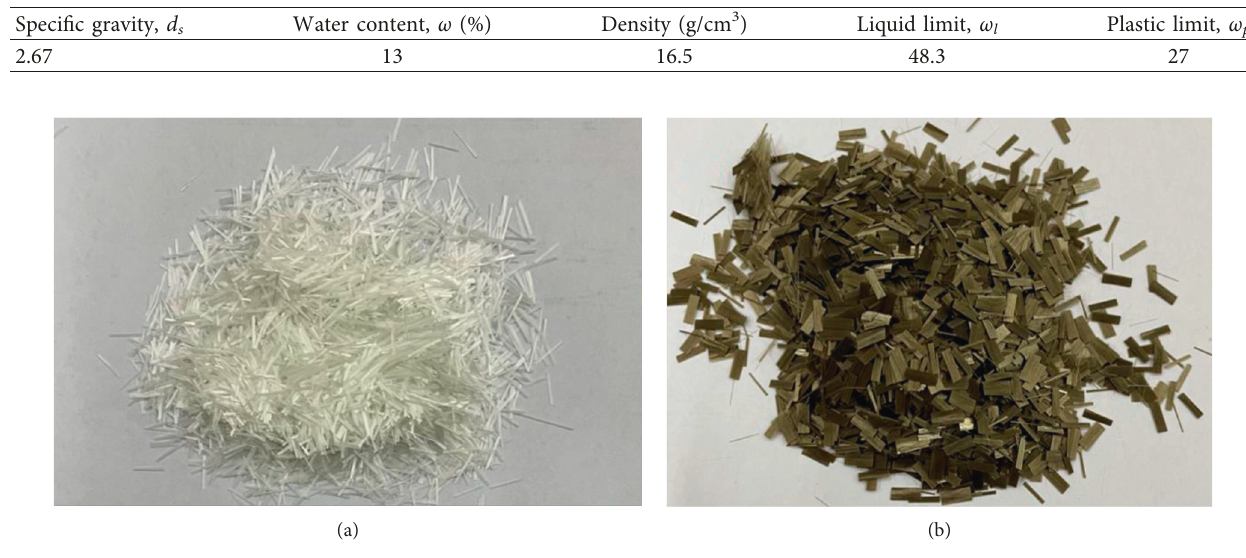
Table 1: Properties of granite residual soil samples.